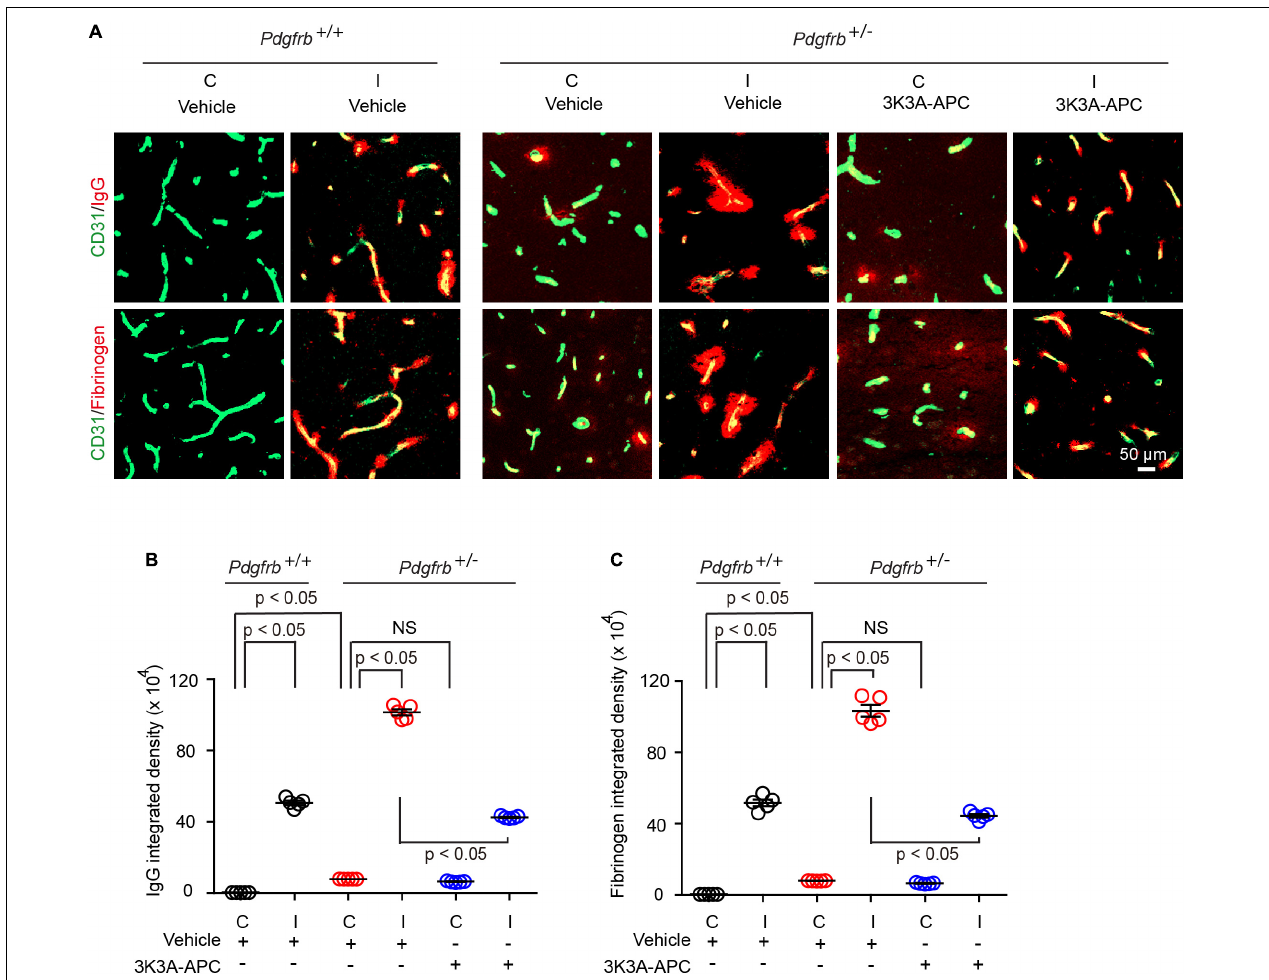
FIGURE 2 | 3K3A-APC protects the blood-brain barrier of pericyte-deficient Pdgfrb + / − mice from post-ischemic damage. (A) Immunostaining for endothelial marker CD31 and capillary ( < 6 µ m in diameter) perivascular deposits of blood-derived immunoglobulin G (IgG, upper row) and fibrinogen (lower row) in non-ischemic contralateral cortex (“C”) and ischemic core of the ipsilateral cortex (“I”) 8 h after tMCAo in Pdgfrb + / + mice and Pdgfrb + / − mice treated with vehicle or 3K3A-APC. Quantification of pericapillary ( < 6 µ m in diameter) IgG (B) and fibrinogen (C) deposits in non-ischemic contralateral cortex (“C”) and ischemic core of the ipsilateral cortex (“I”) 8 h after tMCAo in Pdgfrb + / + mice and Pdgfrb + / − mice treated with vehicle or 3K3A-APC. In (B,C) , mean ± SEM, n = 5 mice per group. The p -values were calculated by one-way ANOVA followed by Tukey’s multiple comparisons